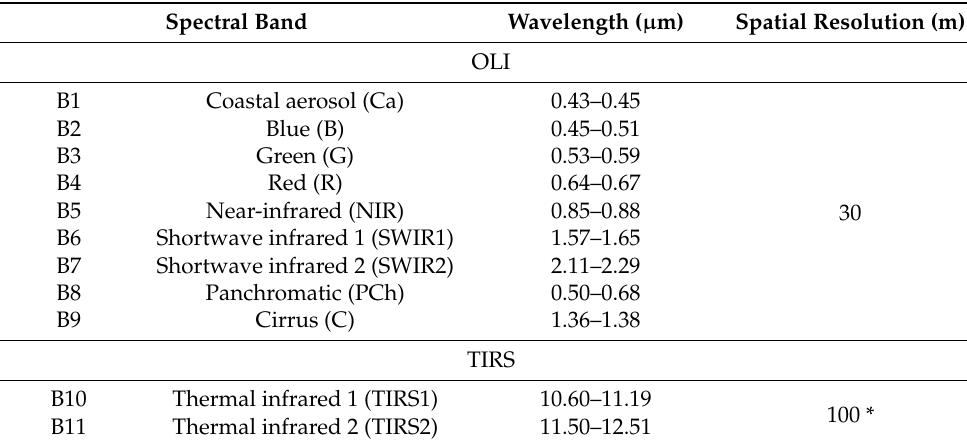
Table 1. Spectral and spatial characteristics of the OLI and TIRS sensor.